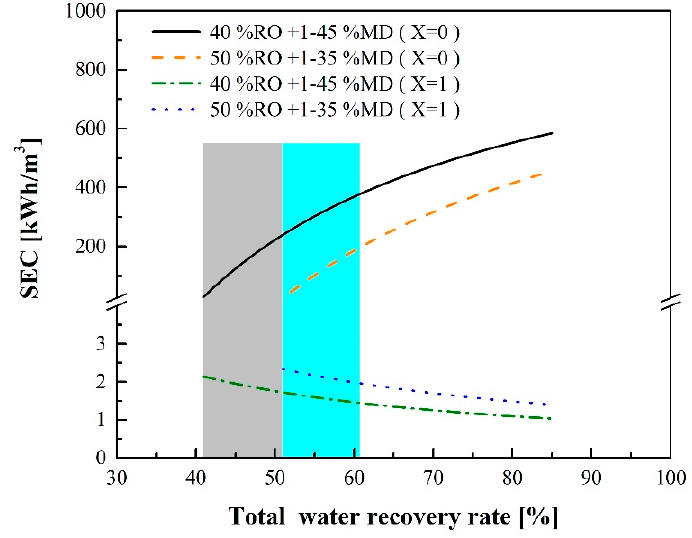
Figure 9. SEC of the RO-MD process with or without waste heat contribution.